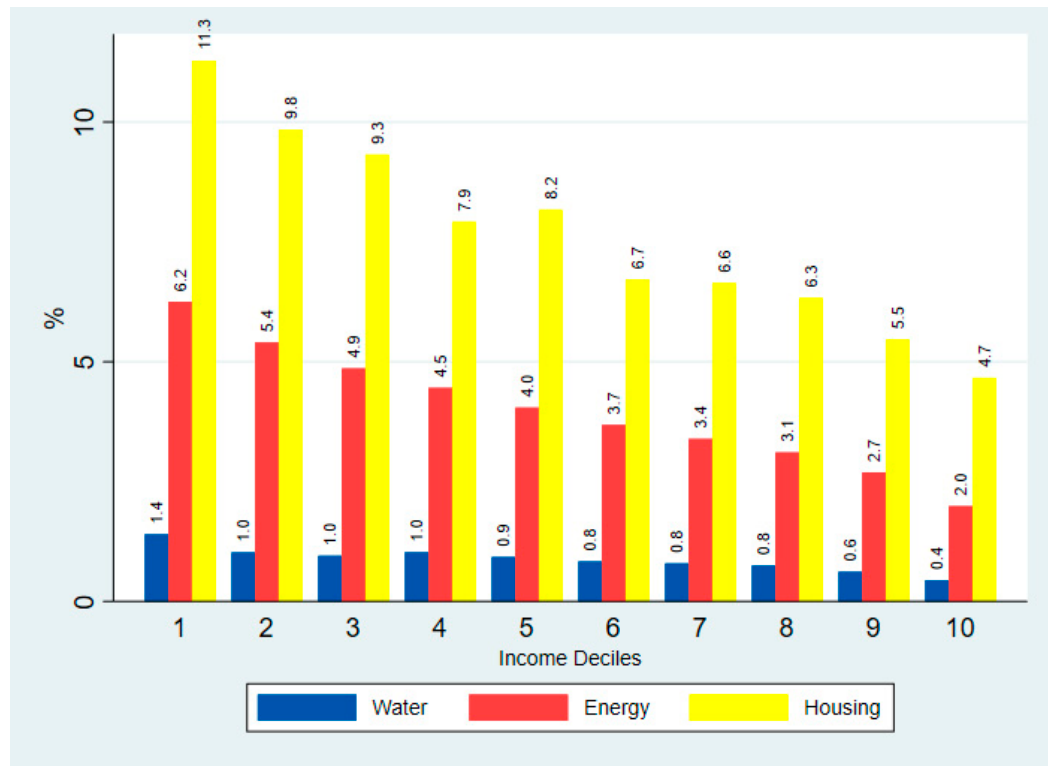
Figure 7. Expenditure in selected categories as percentage of household’s total income. Source: Authors’ elaboration using data from ENIGH [25].